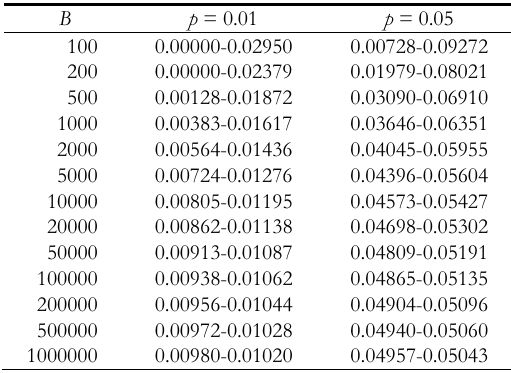
95% probability intervals for estimated p-values B